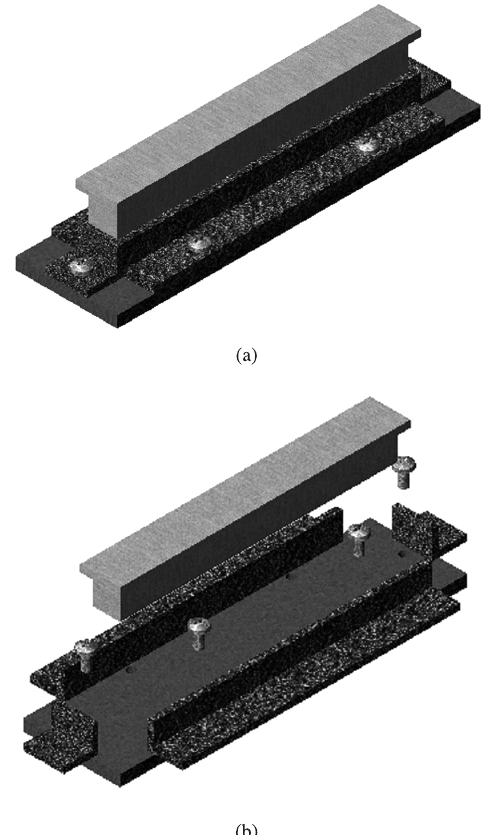
Figure 1. View of the processing matrix: a) closed; b) open for mold release and